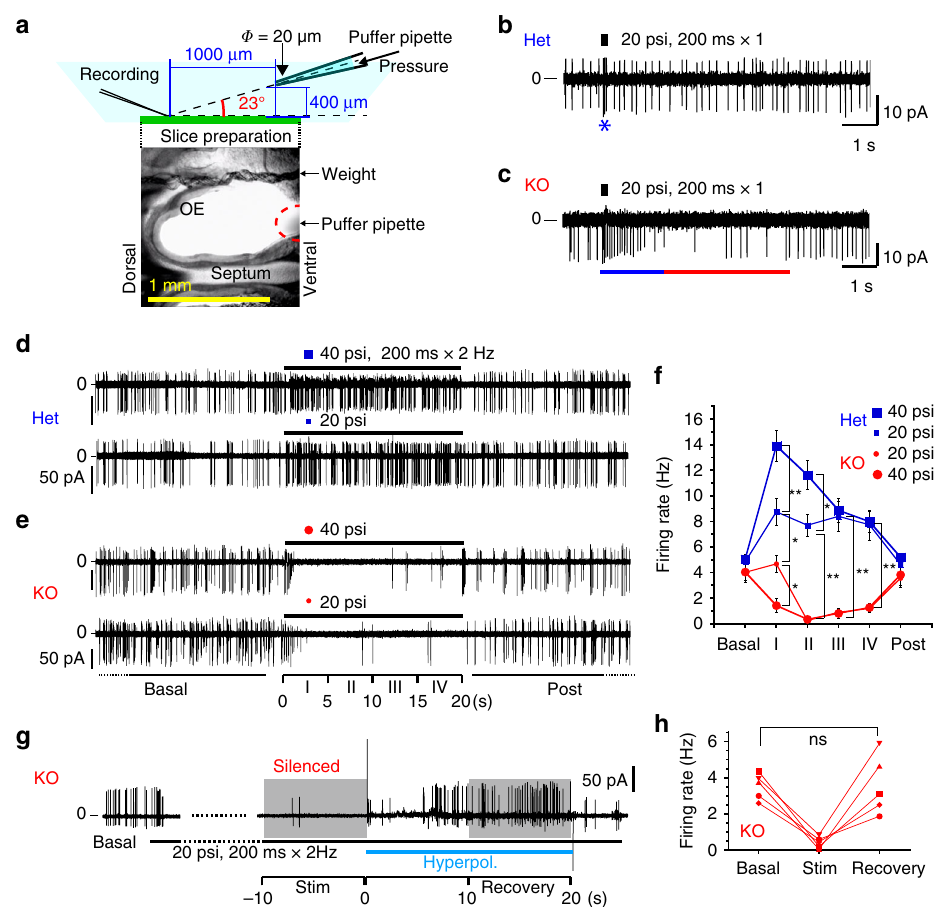
Fig. 5 OMP-KO neurons are silenced by mechanical stimulation. a Setup for electrical recordings of ORN fi ring under mechanical puff stimulation. b , c Representative traces of fi rings induced by a single mechanical stimulus in ( b ) Het and ( c ) KO neurons. psi = pound-force per square inch. To de fi ne the boundaries of the accelerated phase (* or a blue bar) or the depressed phase (a red bar), the average of two adjacent ISIs was compared with ISI Basal . d , e Representative traces of fi rings induced by repetitive mechanical stimuli in ( d ) Het and ( e ) KO neurons. A stimulating puff with a duration of 200 ms at 2 Hz was applied for 20 s. f Time courses of the spontaneous- and mechanically induced fi ring rates of ORNs. The spontaneous fi ring rates before and after stimulation (basal and post) were calculated in 1-min bins, and the parastimulatory fi ring rates were calculated in 5-s bins (I – IV). n = 11 and 8 KO neurons; 9 and 13 Het neurons for 20 and 40 psi. * P < 0.05; ** P < 0.01. g , h Representative trace and summary of the recovery from silencing in KO ORNs by a hyperpolarisation pulse from outside with a sudden increase in Vp to + 60 mV. Statistics: ( f ) one-way ANOVA and post hoc Bonferroni multiple- comparison test for different stimulation strengths (20 and 40 psi); n = 9 – 13 ORNs from 3 Het mice and 9 – 11 ORNs from 3 KO mice. Basal, i, ii, iii and iv, and Post: F (6, 39) = 1.317, P < 0.0001; F (6, 39) = 31.69, P < 0.0001; F (6, 39) = 47.54, P < 0.0001; F (6, 39) = 28.61, P < 0.0001; F (6, 39) = 24.65, P < 0.0001; F (6, 39) = 1.674, P = 0.19, respectively. Bonferroni test: * P < 0.05; ** P < 0.01; P > 0.05 for all the other pairs. h Paired two-sided T test; no signi fi cant difference (ns), n = 5 recordings. Mean ±